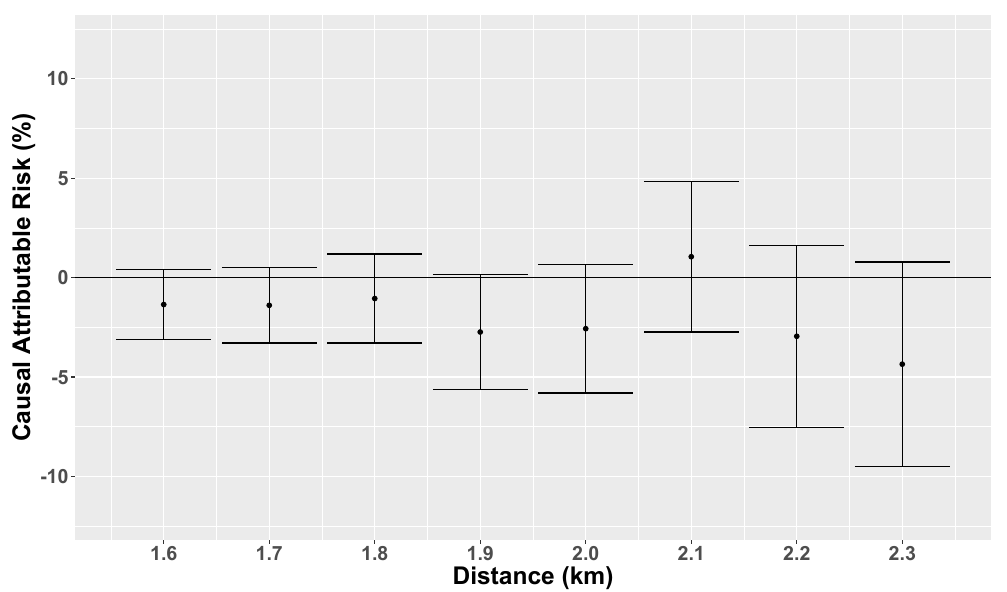
Figure A1. Estimated CAR of asthma in children, expressed as percentage points with whiskers indicate 95% confidence intervals and different distances to the gold mine. Data from children living in a rural mining community in the north of Chile,